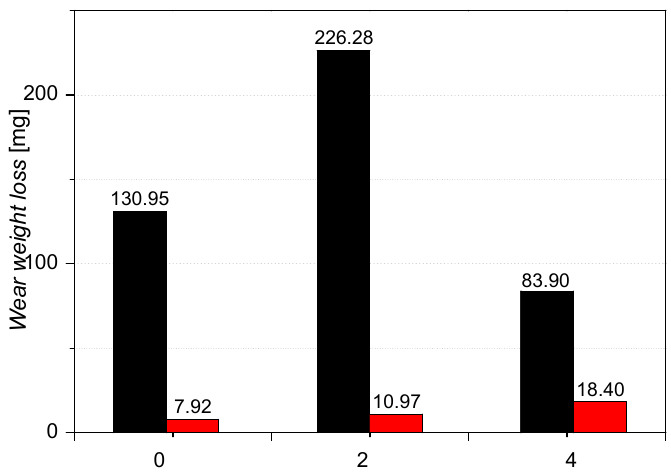
Figure 11. Weight loss of the pin (red) and disc (black) for the tests carried out on the pin-on-disc stand.